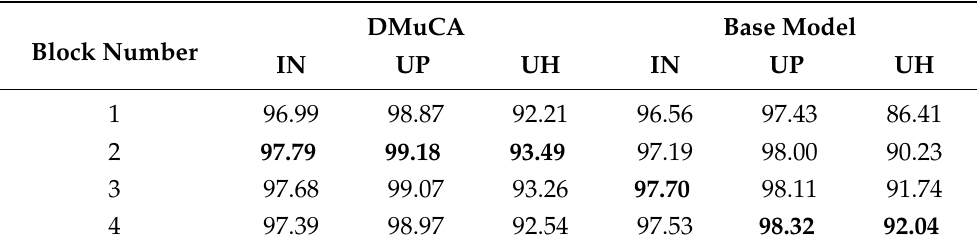
Table 8. Comparison of our proposed DMuCA network and the ResNet backbone with increasing number of residual blocks (OA%). The best results are highlighted in bold font.